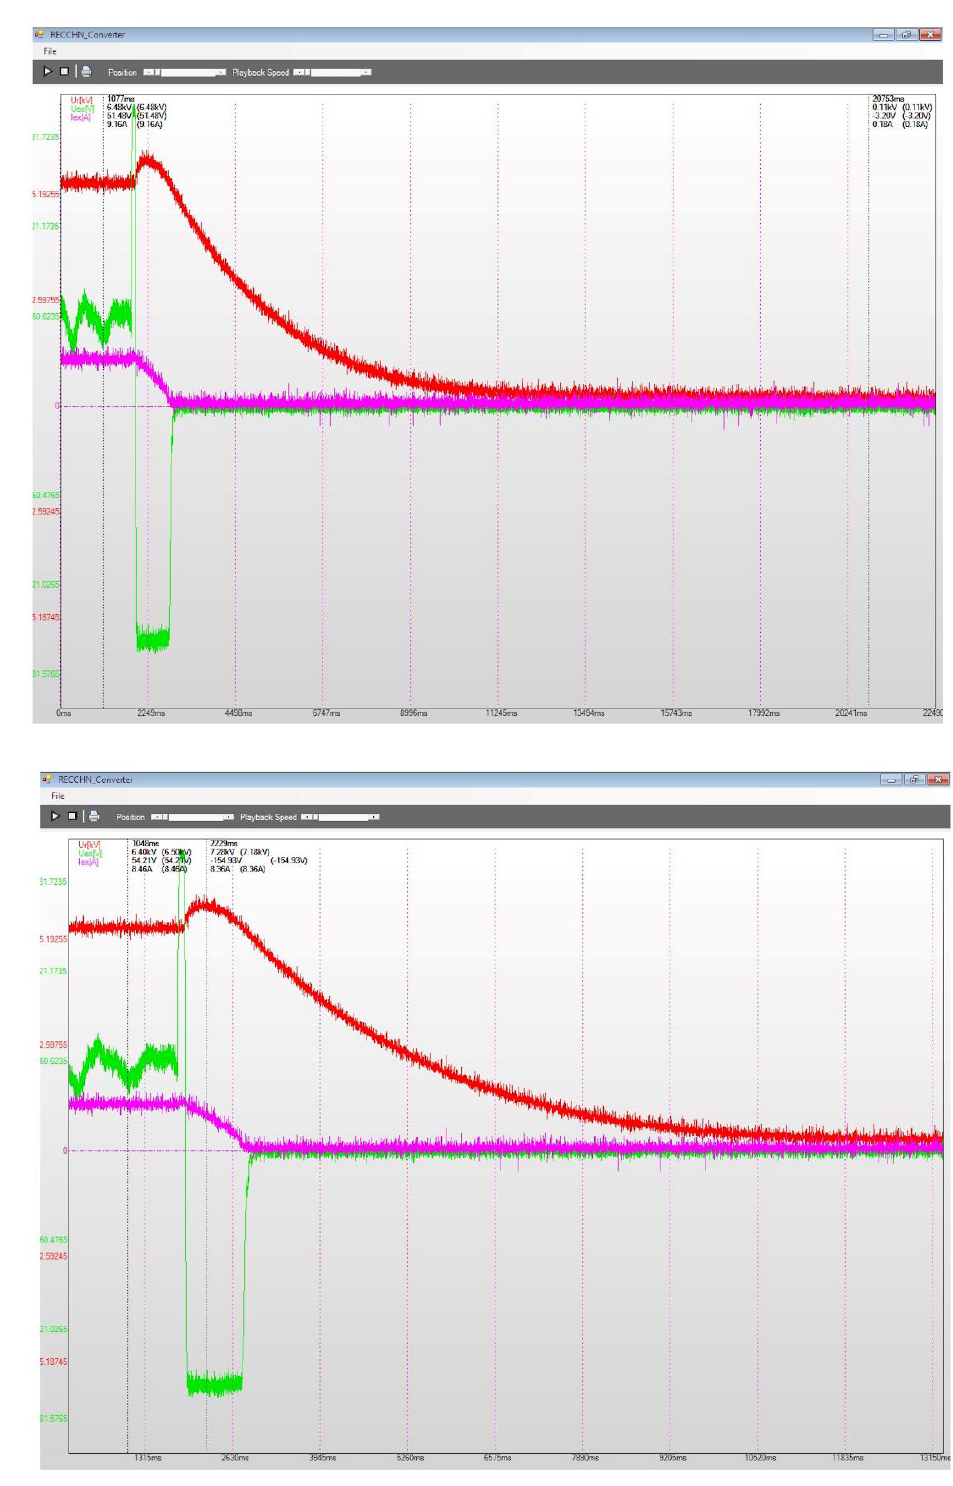
Figure 17. Power − off generator with electric charge throwing, CHE Gura Lotrului, Vâlcea, before and at the end of transient regime (top diagram), also before and during the transient regime (bottom diagram).